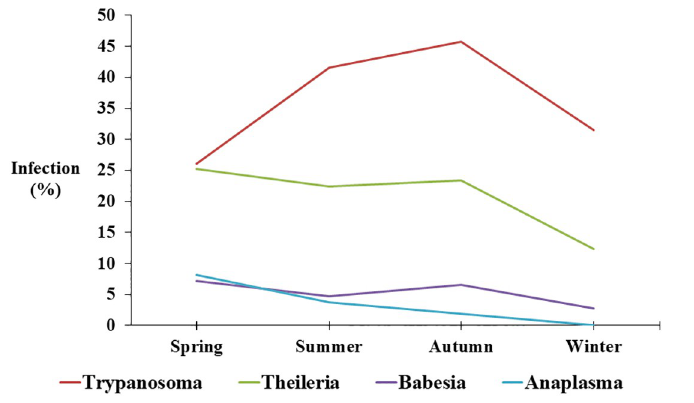
Fig 3. Seasonality of blood parasites detected in blood smears.